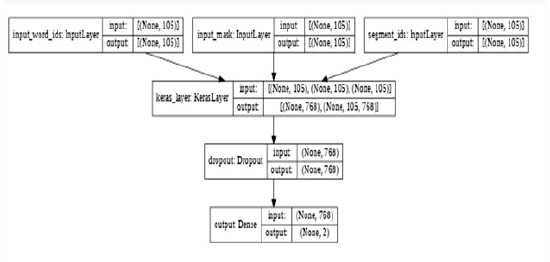
Fig.1. BERT model based on sentiment analysis